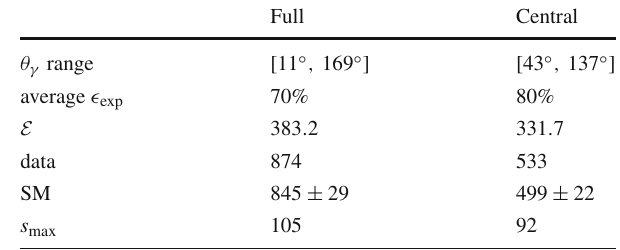
Table 8 LEP data, expected number of events and corresponding CLs limit for the single high-energy photon selection for the two consid- ered angular ranges of the photon. We also list the considered average detector